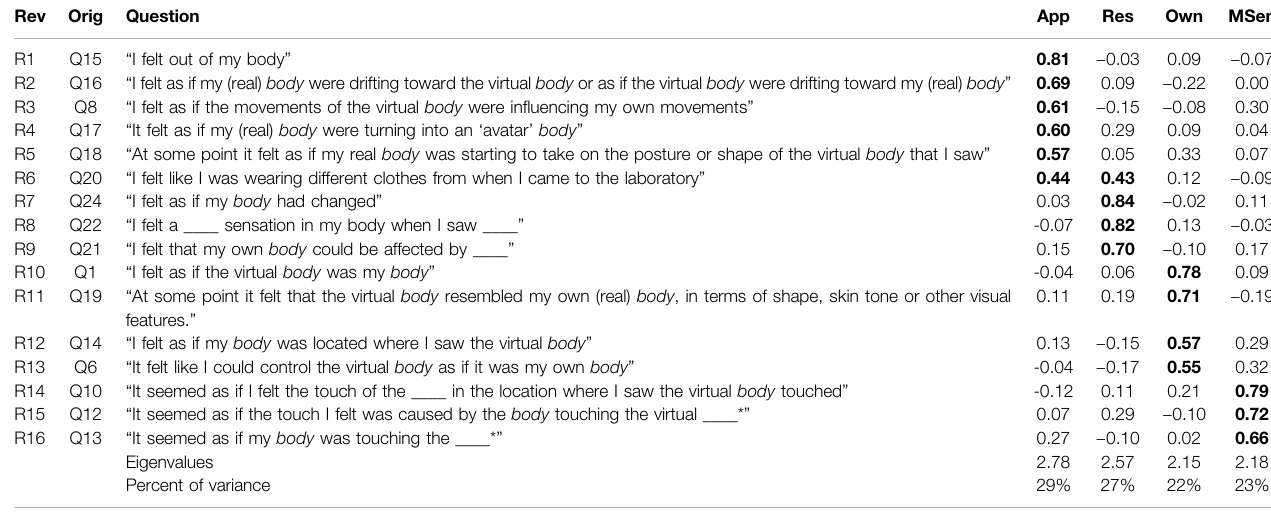
TABLE 2 | Final Analysis with four factors extracted. References in the questionnaire to body would need to be updated if only a body part is being explored. Blank spaces____depend on the experiment, and the ones referring to touch (marked with *) can be fi lled with fl oor , if there are no further tactile stimuli.